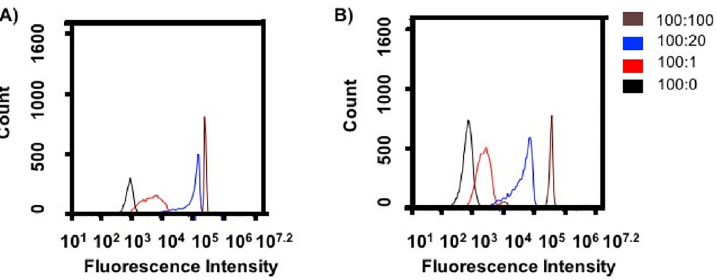
Fig 3. Variable IgG density on spherical and rod shaped particles. Histograms of fluorescence intensity of FITC labeled secondary anti-rabbit IgG added to (A) spherical and (B) rod shaped particles as measured by flow cytometry. Density is presented as the ratio BSA:IgG. Representative traces are shown, which were consistent across two independent batches of ligand coated particles.